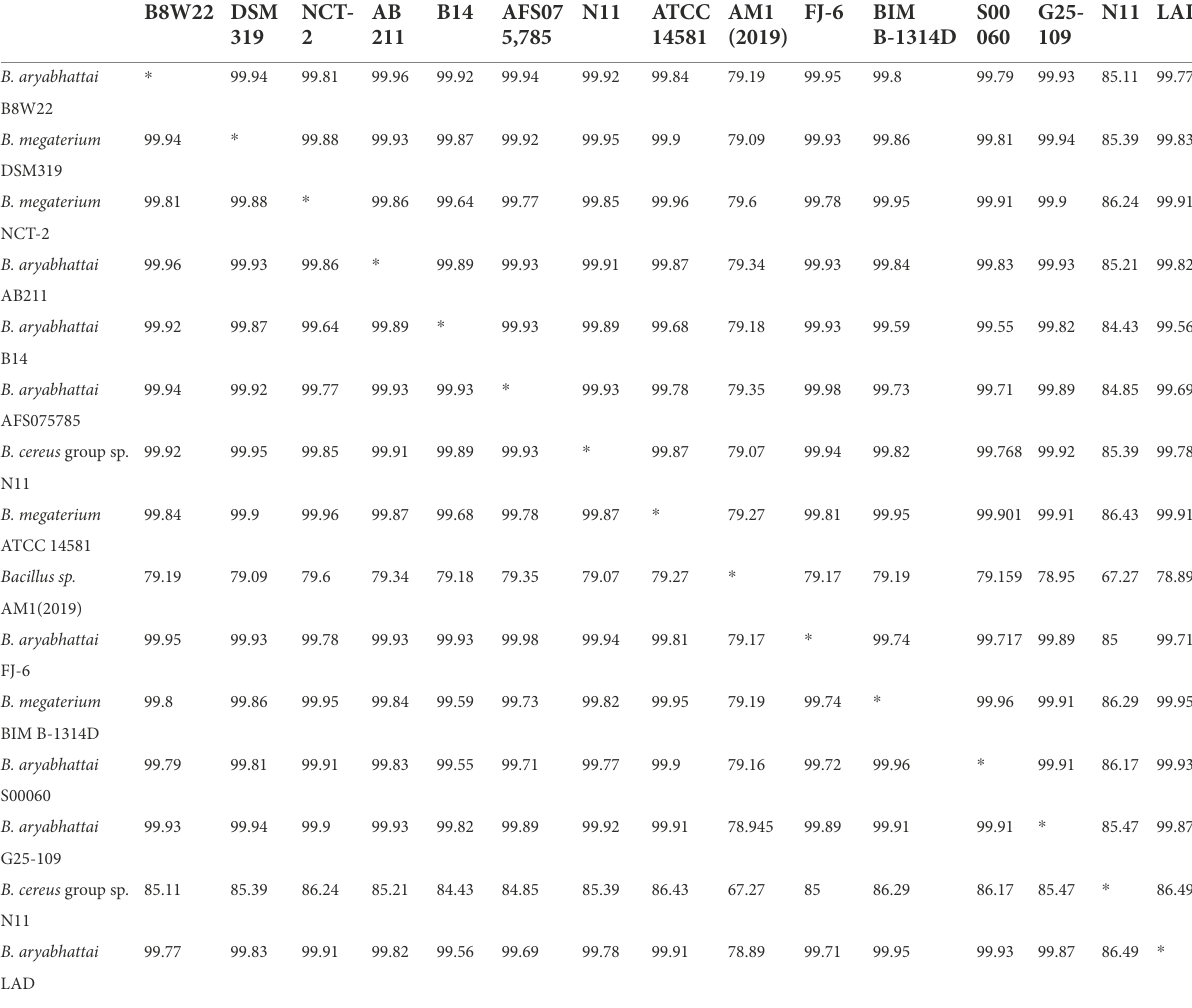
TABLE 4 Average nucleotide identities (ANI) analysis for pairwise genome comparison between B. aryabhattai LAD and other Bacillus strains.